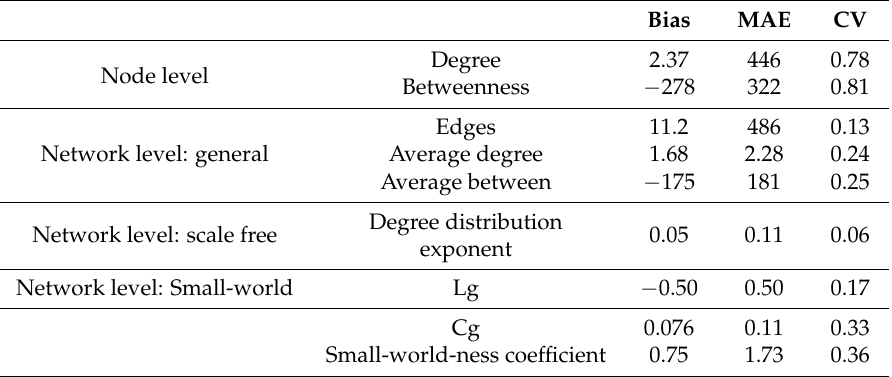
Table 5. Mean Bias, Mean Absolute Error, and CV for main measures.